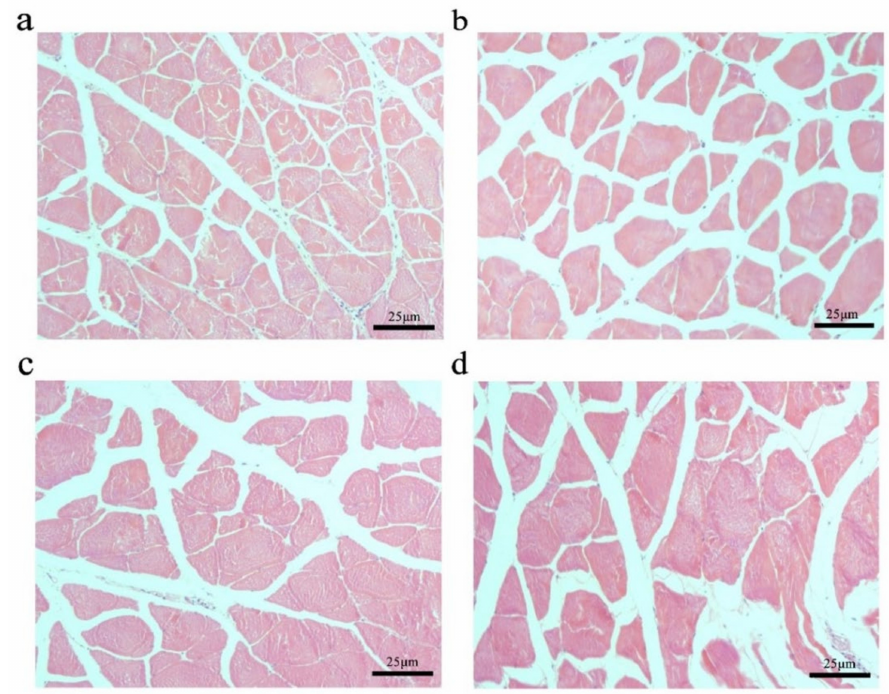
Figure 3. Changes in muscle fibers of E. coioides after immunization. ( a ) HE staining of paraffin sections of muscle fibers in the control group; ( b ) HE staining of paraffin sections of muscle fibers in the immunized 50 µ g vaccine group; ( c ) HE staining of paraffin sections of muscle fibers in the immunized 100 µ g vaccine group; ( d ) HE staining of paraffin sections of muscle fibers in the immunized 200 µ g vaccine group.